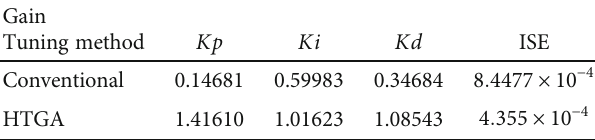
Table 1: Optimal gain of PID and performance indices.